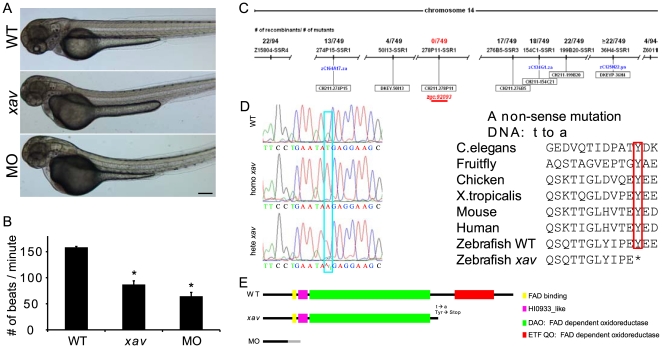
External phenotype, genotype, cloning and morpholino phenocopy of xav mutants.
A. External xav and etfdh morphant (MO) phenotypes at ∼60 hpf include a bent and thinner tail and smaller head and eyes. Scale bar = 100 µm. B.
xav mutants and MO exhibit slower heart beat (WT 158±6 beats/minute, N = 13 embryos; xav 87±7; N = 14 embryos; MO 65±7, N = 14 embryos; one-way ANOVA, followed by Dunn's pairwise comparison, * p<0.001. C. Genetic and physical map of the xav (zgc∶92093) locus (red), including microsatellite and SSR markers, number of recombinants, and BAC clones from the T51 radiation hybrid panel. D.
etfdh mutation in xav is a T to A mutation (blue box) resulting in a premature stop codon (red box). The amino acid sequence of etfdh is highly conserved among several species, from C. elegans to human. E. Schematic location of xav mutation, resulting in truncation of the C terminal. etfdh MO is predicted to give rise to a protein fragment lacking all functional domains.